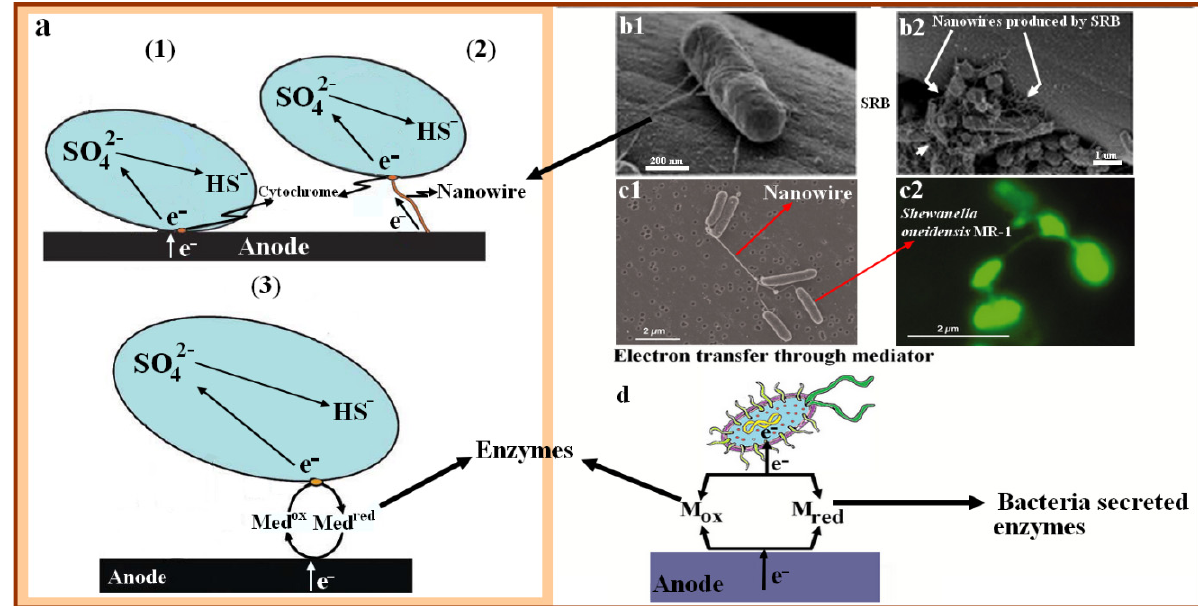
Figure 4. Schematic illustration of electron transfer ( a ): direct electron transfer through cytochrome (1); electron transfer through nanowires and mediators is shown by (2) and (3) Reprinted with per